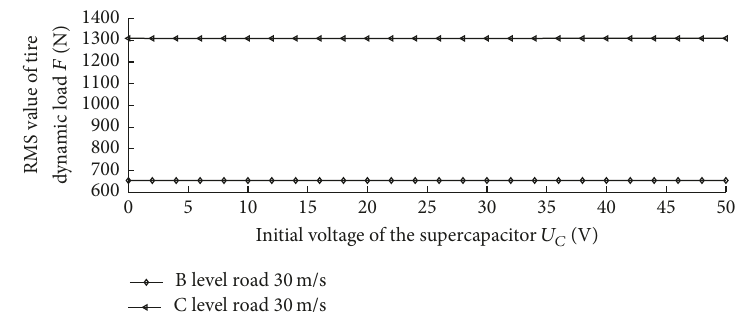
Figure 5: The relationship between tire dynamic load and supercapacitor initial terminal voltage.